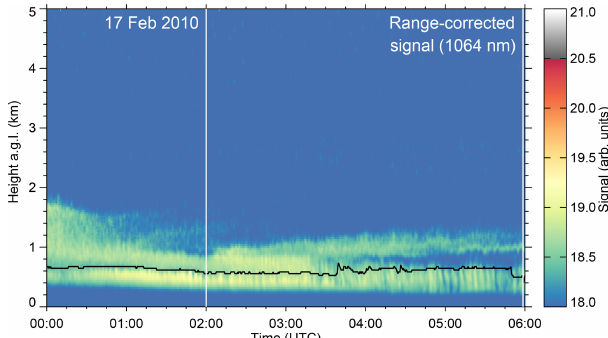
Figure 8. Height–time display of the range-corrected signal ob- served at 1064nm with the Polly XT lidar on 17 February 2010. The analysed period between 02:00 and 06:00UTC is framed in white. The planetary boundary layer top height is indicated by the black line.